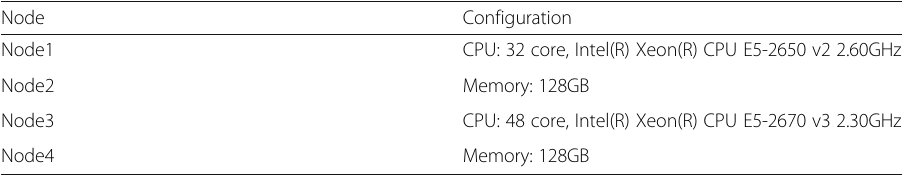
Table 1 Test cluster node hardware configuration details Node